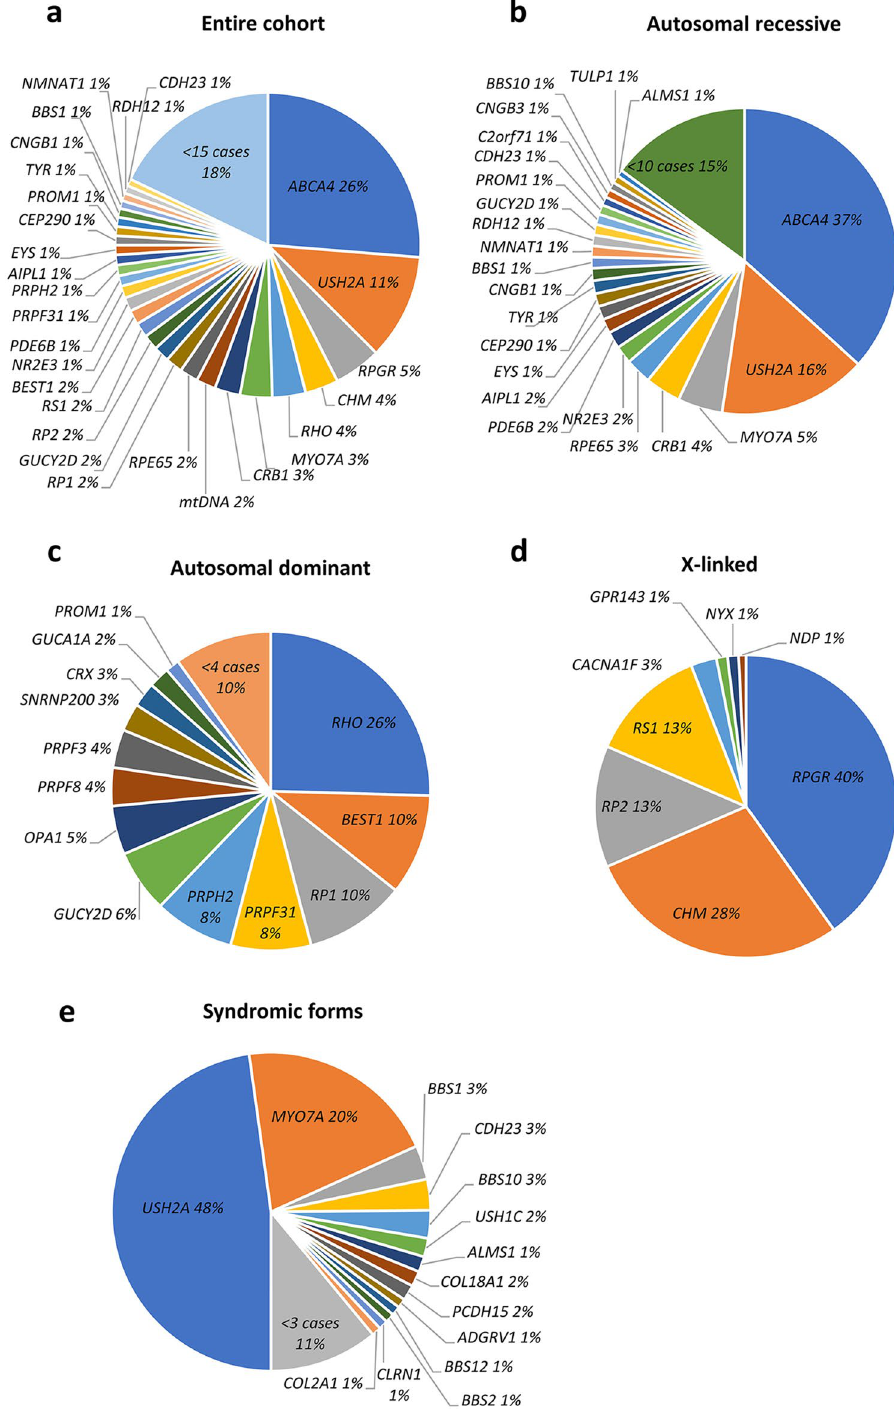
Figure 2. Distribution of different types of alleles in the solved cohort. ( a ) Pie chart showing the relative contribution of each causal IRD gene in disease pathogenesis of the genetically defined cohort. Genes (n = 99) implicated in less than 15 cases are plotted as a single group. ( b – d ) Pie chart depicting the prevalence and relative contribution of causative genes implicated in autosomal recessive ( b ), autosomal dominant ( c ) and X-linked ( d ) retinal dystrophy forms. Genes that are responsible for IRD pathogenesis in less than 10 cases with autosomal recessive (or less than 4 cases with dominant) forms are depicted as a single group. ( e ) Contribution of the most recurrent IRD-associated genes involved in syndromic forms. Genes implicated in less than 3 cases are plotted as a single